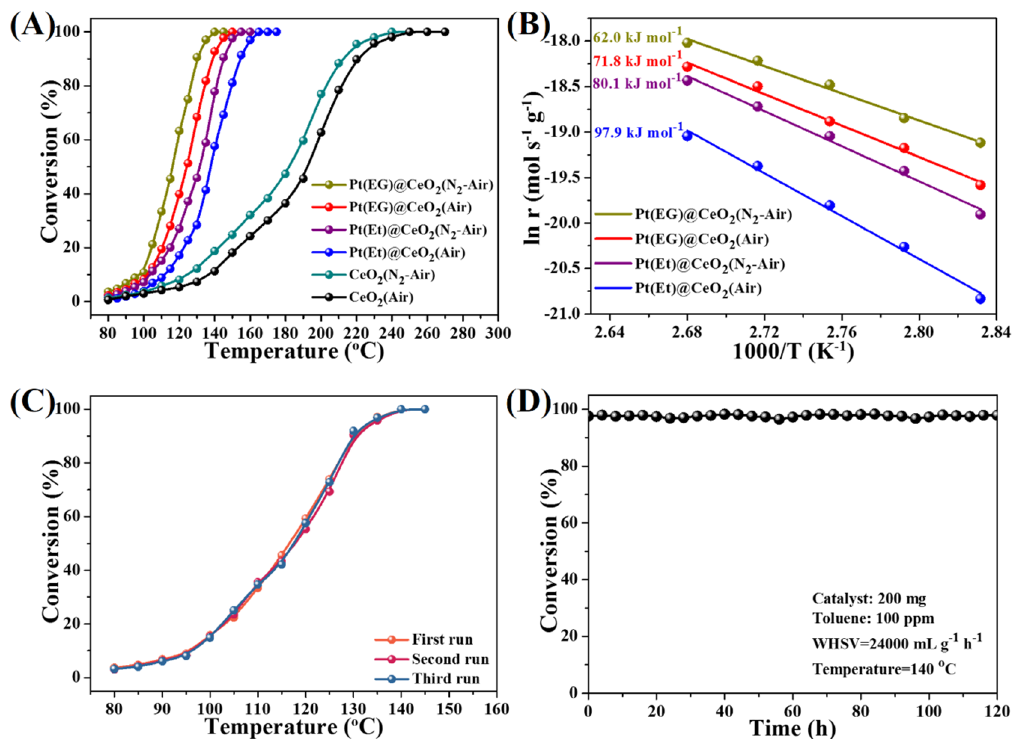
Figure 5. ( A ) Conversion of toluene over various functional MOF derivatives. Catalyst: 200 mg; Toluene concentration: 100 ppm; WHSV: 24,000 mL g − 1 h − 1 . ( B ) Arrhenius plots for the